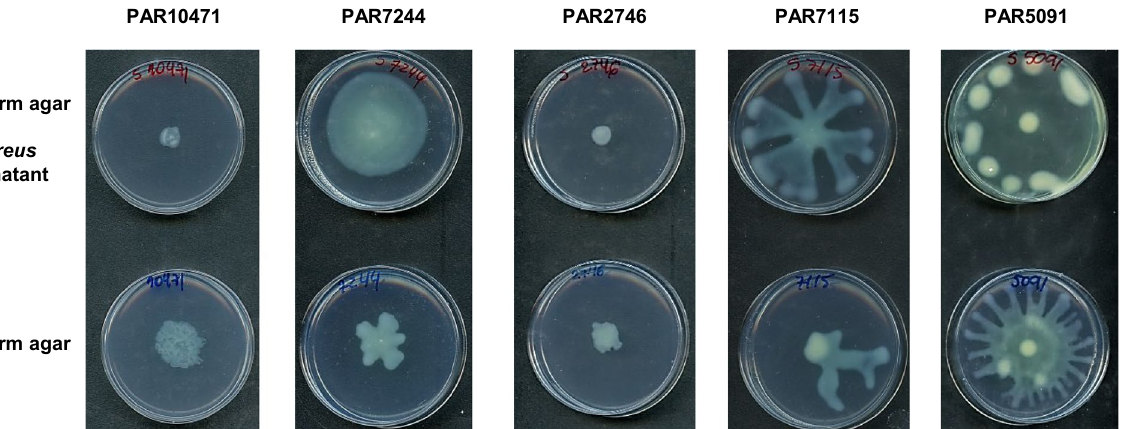
Figure 4. Effect of S. aureus supernatants on swarming motility of P. aeruginosa . Swarming motility was evaluated both in the absence and presence of the corresponding S. aureus supernatant diluted 1:10 in swarming medium (BM2 with 0.5% agar). Plates were incubated at 37 °C for 20 h. Images are representative of triplicate